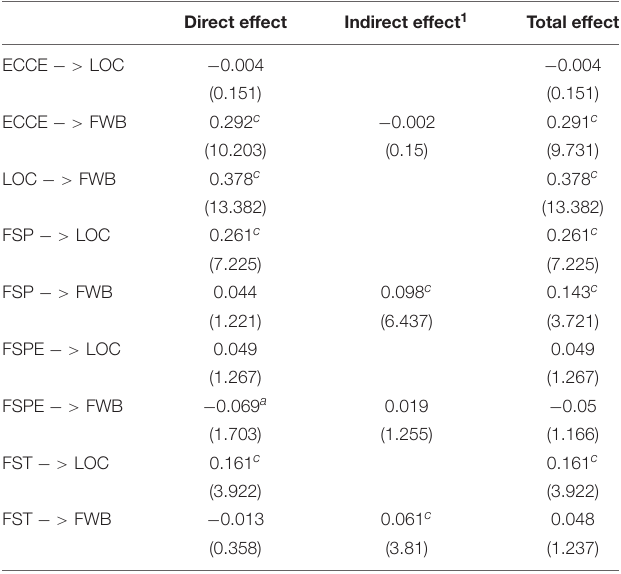
TABLE 4 | Direct, indirect and total effect of the